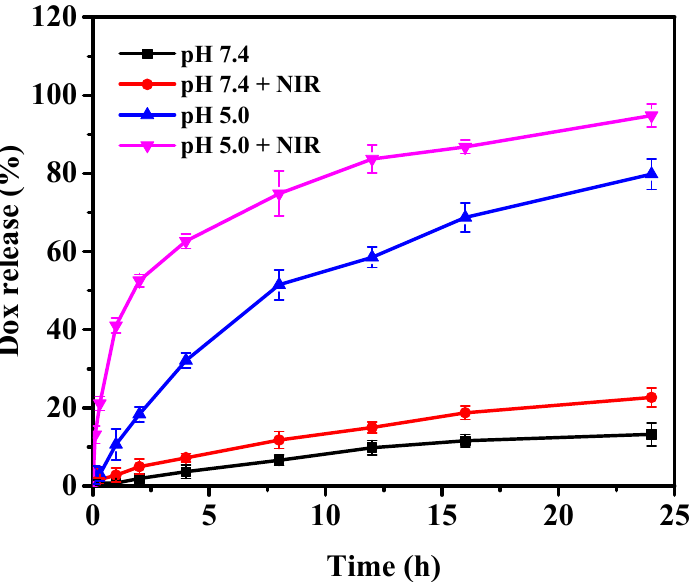
Figure 5. % Dox release at pH 7.4 and pH 5.0 with and without NIR irradiation for 10 min at 808 nm, 2 W/cm 2 ( n = 3).